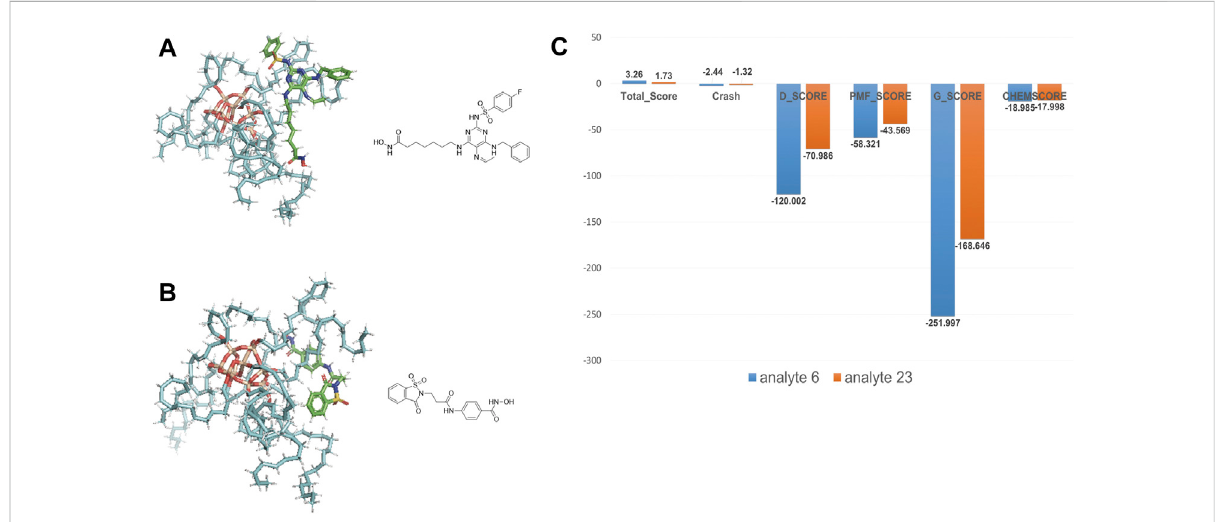
FIGURE 6 (A) The docking result of analyte 6. (B) The docking result of analyte 23. (C) Comparison of molecular docking scores (molecular interaction- based features) of analyte 6 and 23.